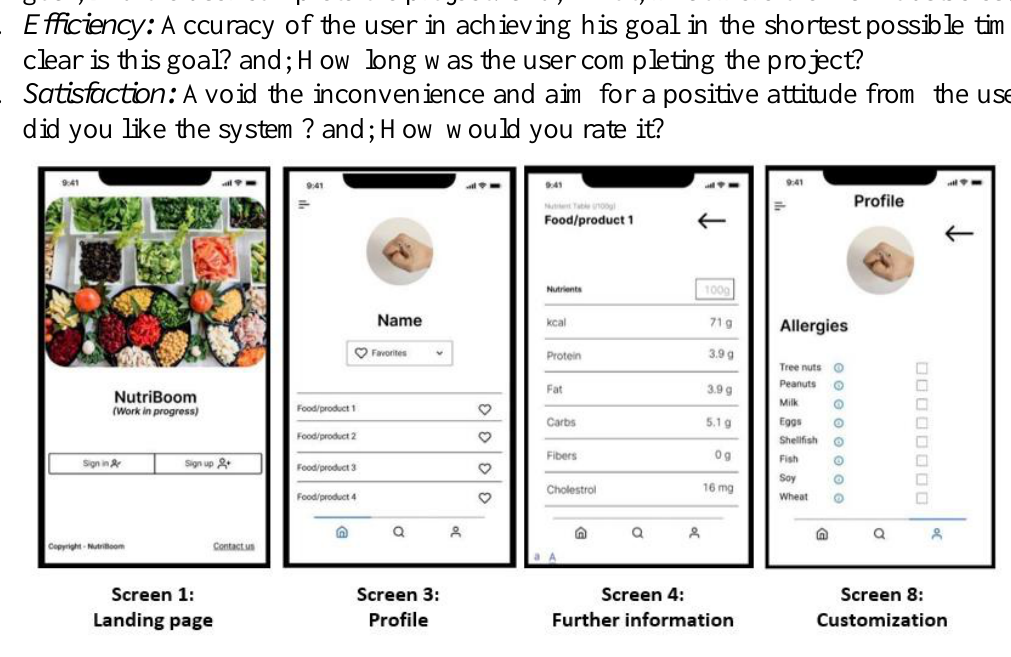
Figure 1. Prototype